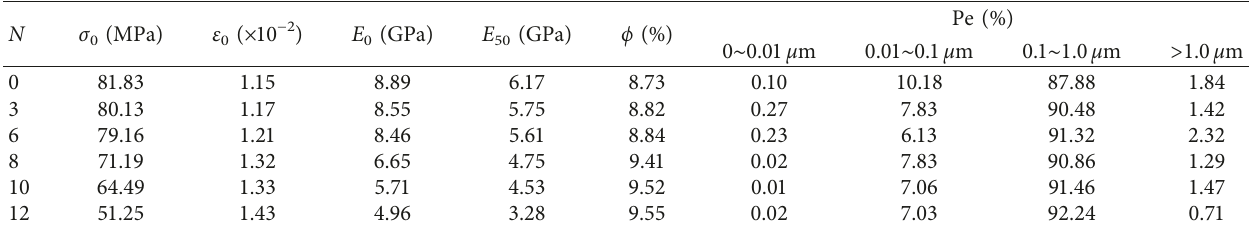
Figure 7: Variations in (a) compression strength, (b) peak strain, (c) elasticity modulus, and (d) secant modulus versus the wetting-drying cycle Table 2: Mechanical and pore parameters of argillaceous limestones after the wetting-drying cycle.